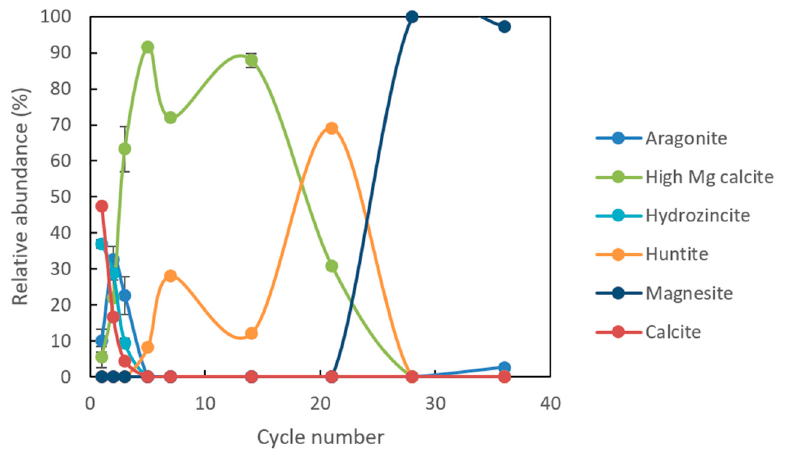
Figure 9. Plot presenting the evolution of the relative abundance of minerals in the reaction products versus cycle number for the second series of pH cycling experiments (with zinc ions). The quantification is based on Rietveld analysis of X-ray diffraction data. The error bars (in light grey) reflect the standard deviation of the results from the triplicate experiments.